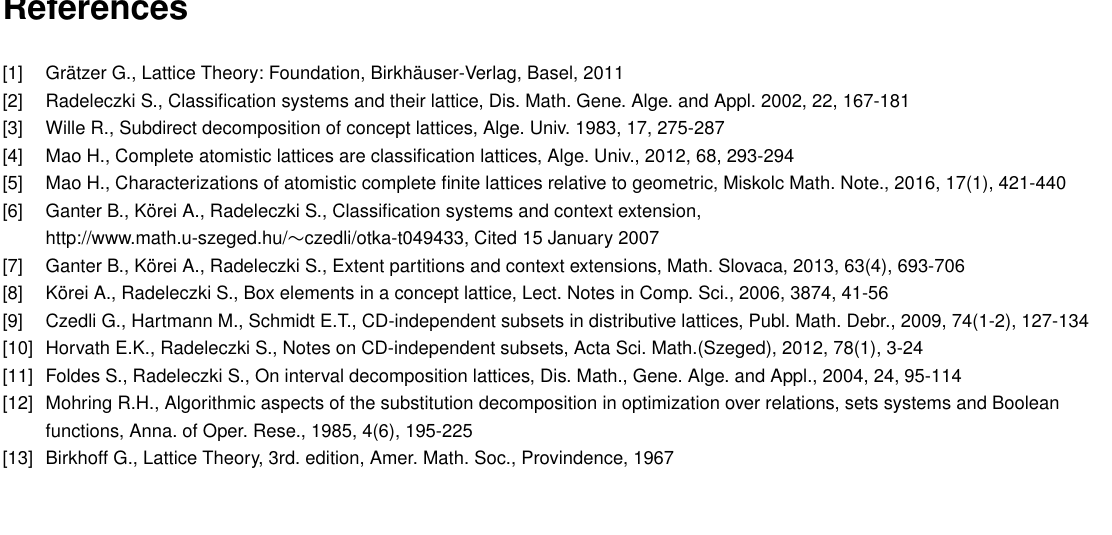
Figure 7 diagram of L 3